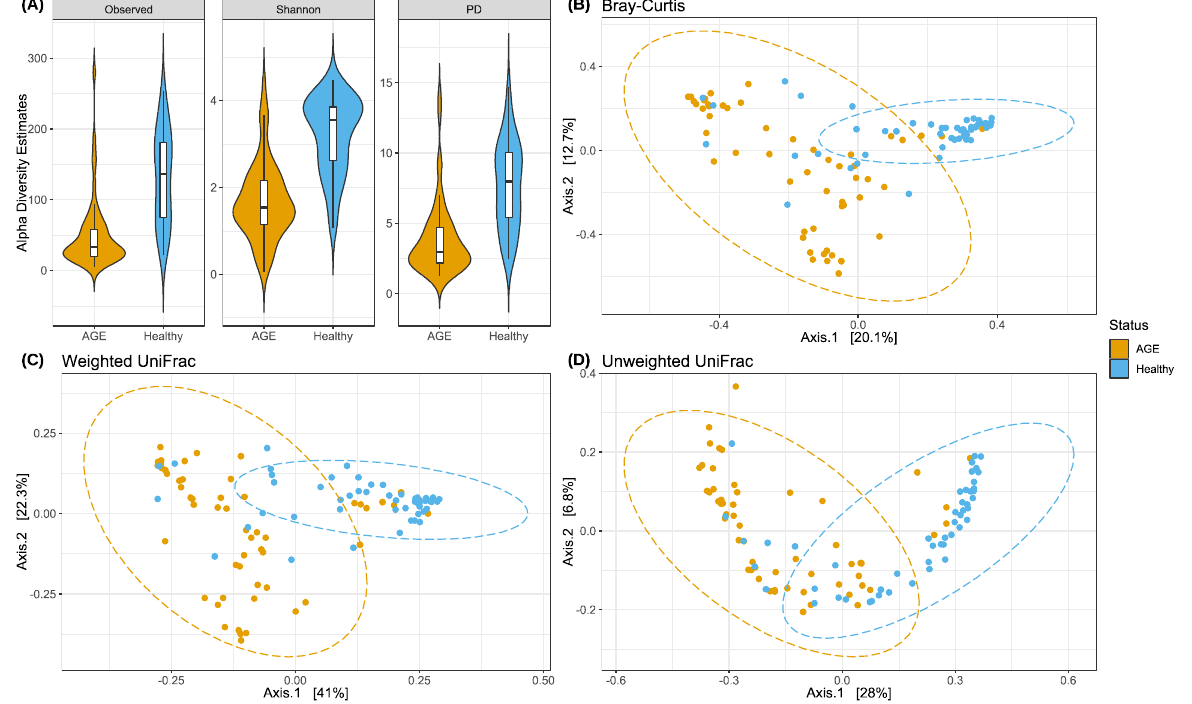
Figure 1. AGE cases are associated with lower alpha diversity and distinct beta diversity relative to healthy controls. ( A ) Violin plot of alpha diversity metrics. Left to right: Observed ASVs ( p < 0.0001, Wilcoxon rank sum test), Shannon ( p < 0.0001, Wilcoxon rank sum test), and phylogenetic diversity (PD) ( p < 0.0001, Wilcoxon rank sum test). Violin plots show the kernel probability density plots of individual alpha diversity estimates. Boxplots show the median (middle line: 50th percentile), first (bottom: 25th percentile), and third quartiles (top: 75th percentile), and whiskers as 1.5 times the interquartile range. Principal coordinates analysis (PCoA) plots of ( B ) Bray–Curtis dissimilarity ( p < 0.001, PERMANOVA R 2 = 0.09) and ( C ) Weighted ( p < 0.001, PERMANOVA R 2 = 0.19) and ( D ) Unweighted UniFrac metrics ( p < 0.001, PERMANOVA R 2 = 0.12). Percentage variation explained on axes 1 and 2 are shown. Ellipses show the 95% confidence interval for the variation within each group. Each dot represents a faecal microbiota sample from a different